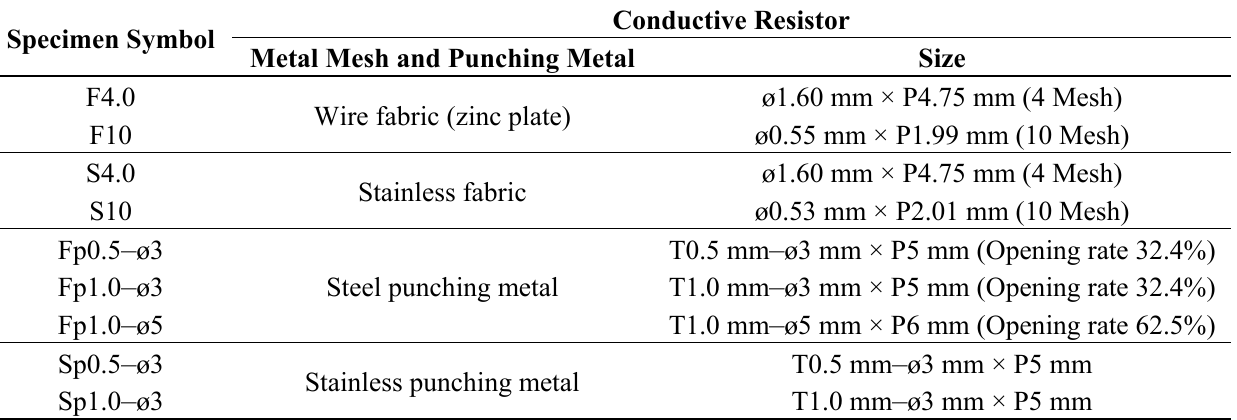
Table 1. Experimental factors for temperature elevation.